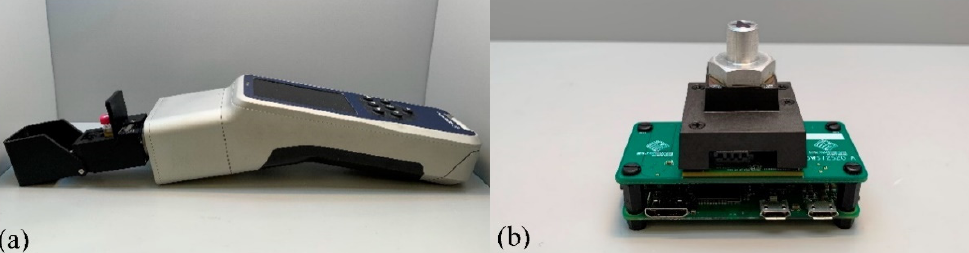
Figure 1. Potato chip oil spectrum acquisition by ( a ) using a handheld Raman instrument equipped with a 1064 nm excitation laser and by ( b ) using a compact Fourier Transform Near-Infrared (FT-NIR) spectral sensor.